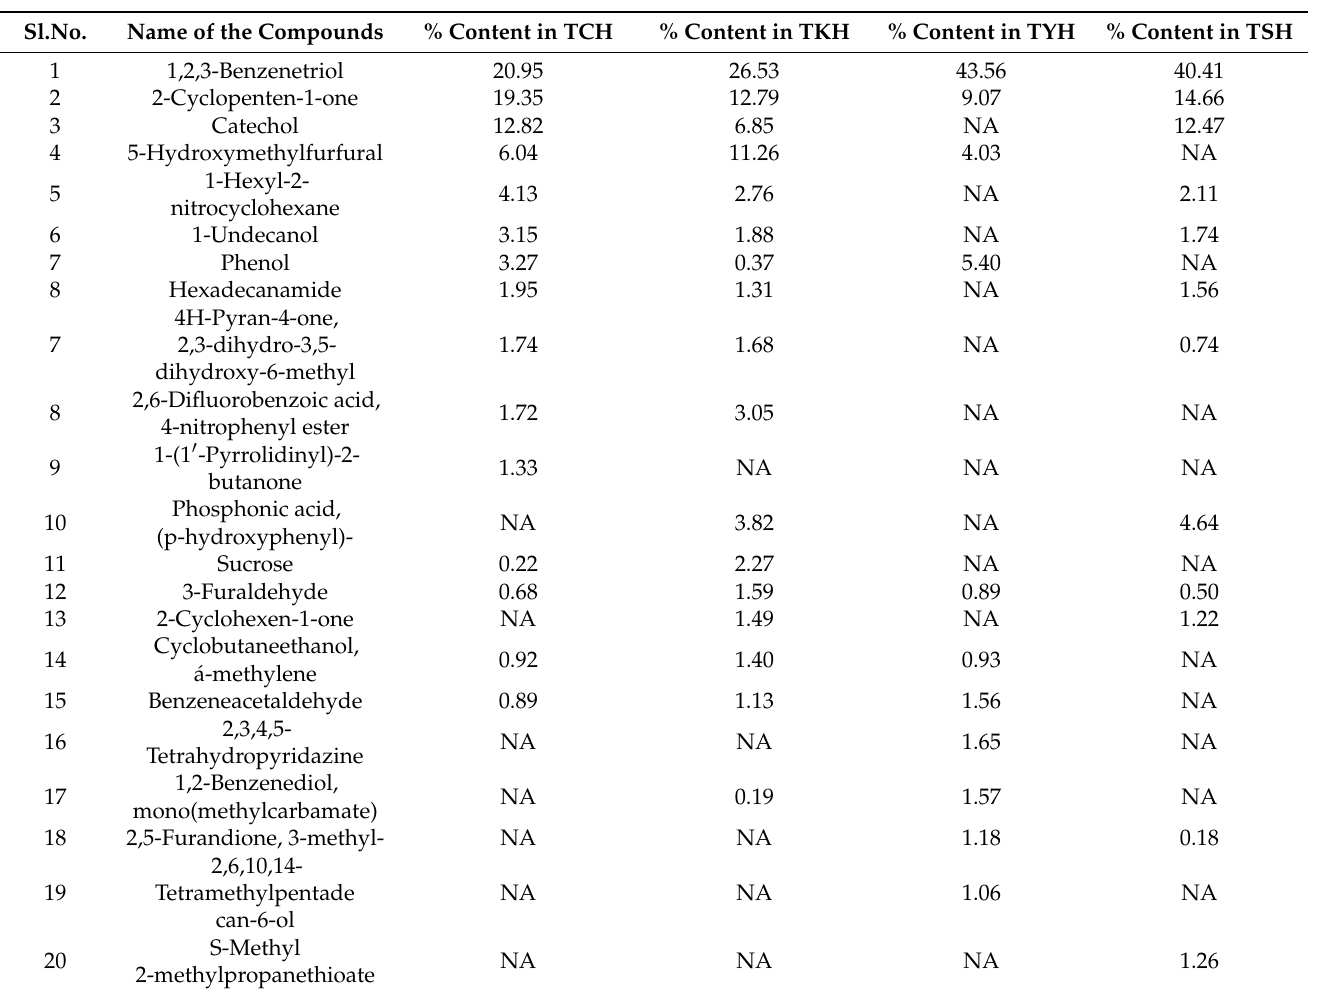
Table 2. Chemical composition of hydroalcoholic extracts of T. chebula collected from different locations